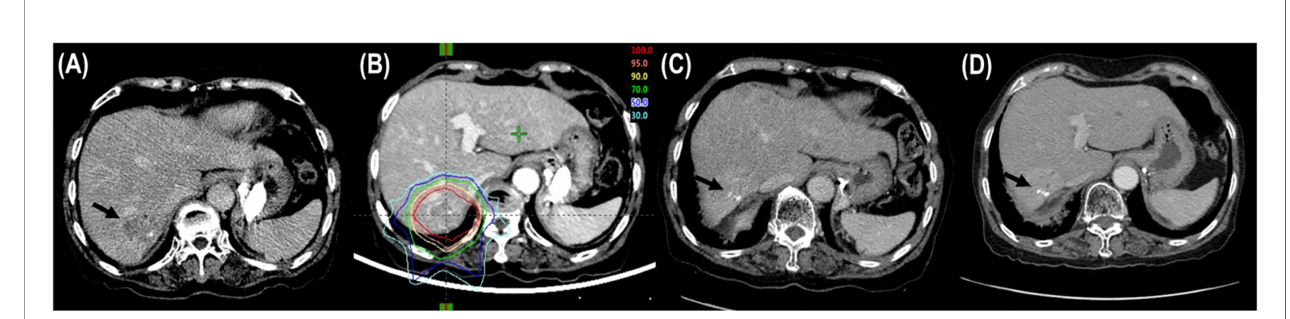
FIGURE 1 | Tumor response after proton beam therapy (PBT). (A) CT scans prior to PBT showing the tumor (arrow). (B) The patient was treated with PBT. (C) CT scans at 6 months after PBT showing shrinkage of the tumor (arrow). (D) CT scans at 12 months after PBT showing complete response of the